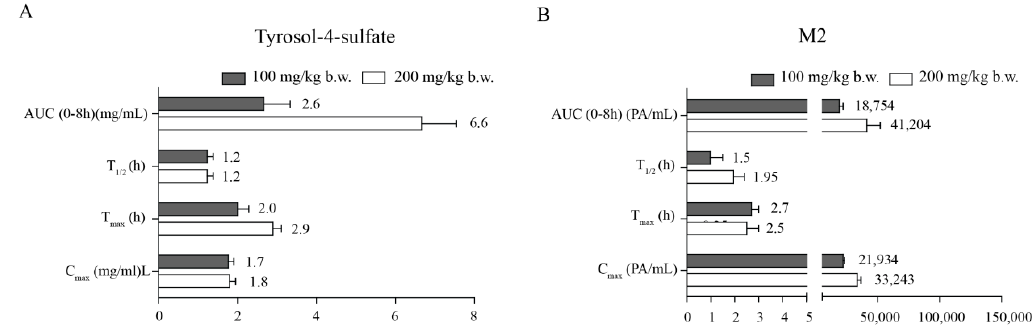
Figure 4. Pharmacokinetic analysis of tyrosol metabolites in rat urine. ( A ) Urine pharmacokinetics profiles of tyrosol-4-sulfate; ( B ) Urine pharmacokinetics profiles of M2. Tyrosol was orally administrated to rats at a dose of 100 ( ♦ ) or 200 mg/kg body weight ( ■ ). PA: peak area; C max : maximum recorded concentration; T max : time to reach C max ; AUC (area under the curve): a measure of drug exposure; T 1/2 : elimination half-life. Each point represents mean ± SD ( n = 3).